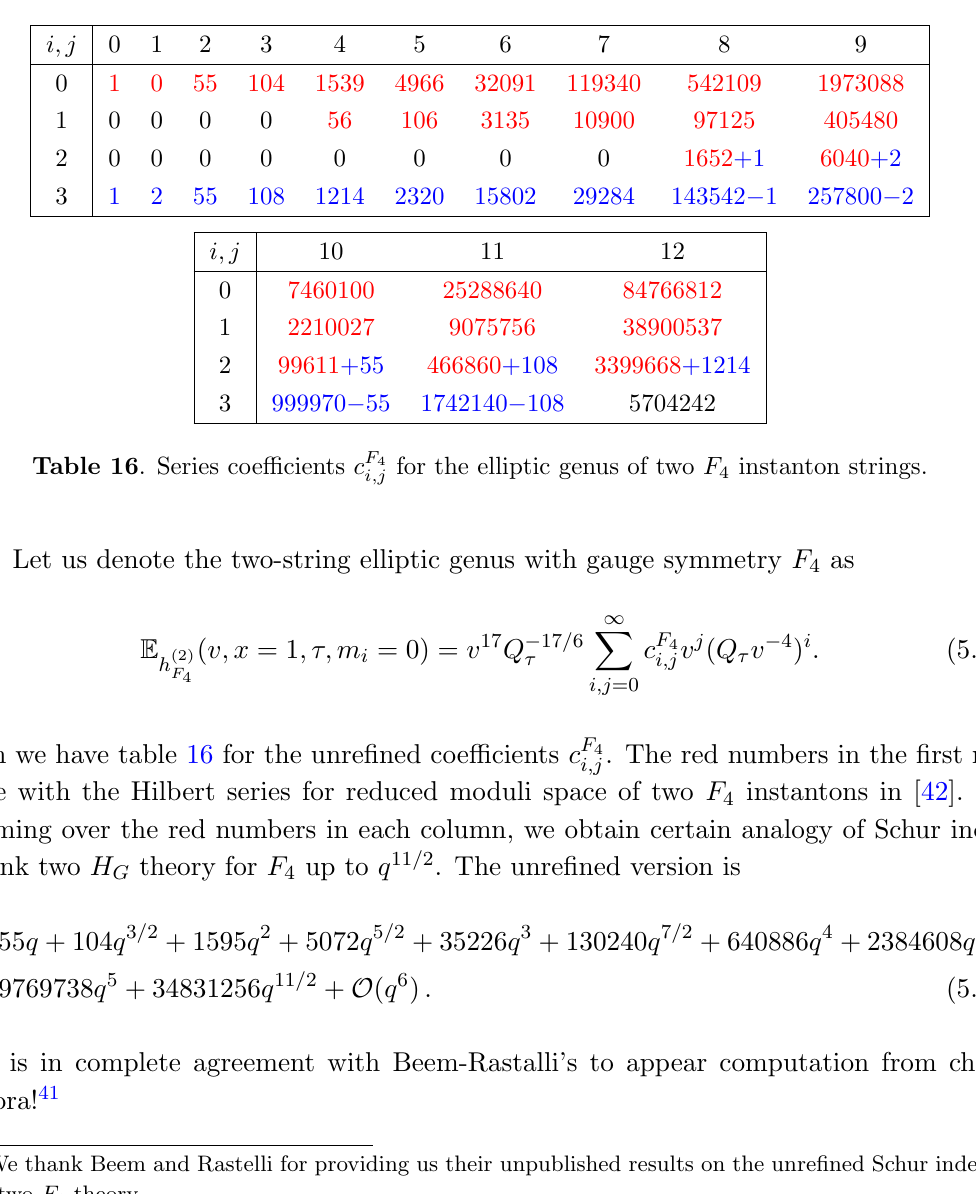
for the elliptic genus of two SO(8) instanton strings. i;j